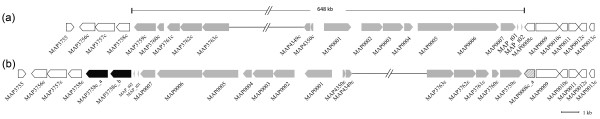
Comparison of the previously-published (a) and revised (b) gene arrangements of the M. ap K-10 genome context examined in this study. Arrows represent size, orientation and order of the ORFs. White arrows represent unchanged ORFs, Black arrows represent new ORFs, hatched arrow represents an altered ORF and gray arrows represent ORFs in the inverted segment.